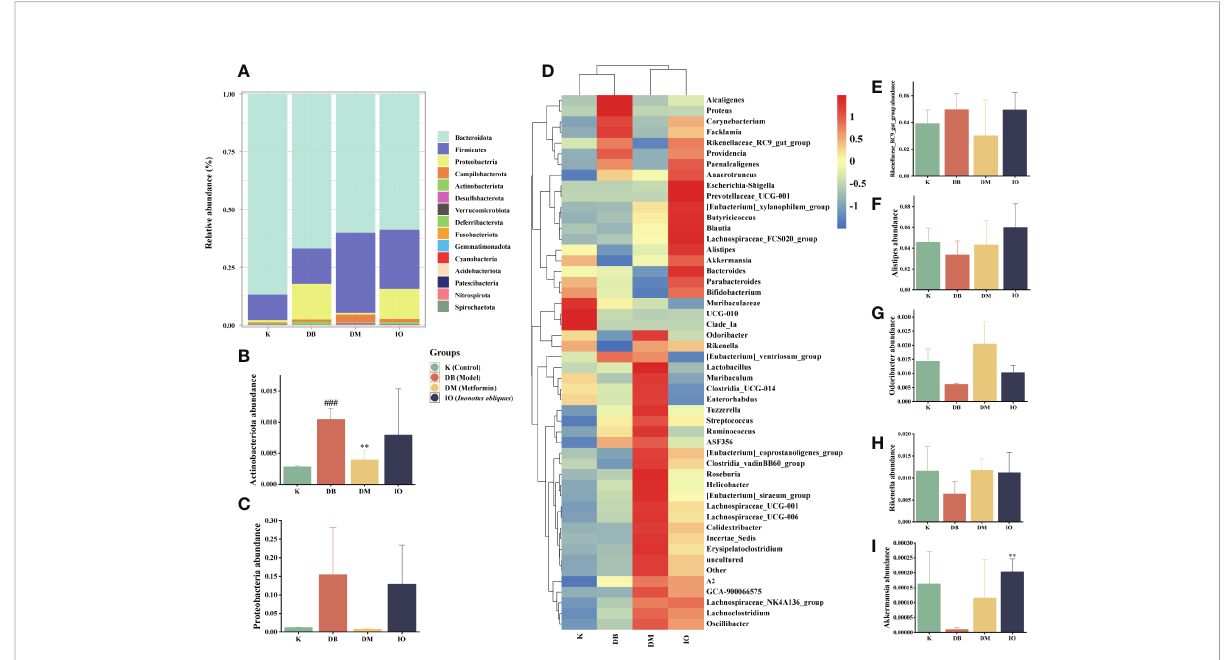
FIGURE 5 Structural changes of intestinal fl ora. Intestinal fl ora species abundance at the phylum and genus levels. (A) The relative abundance of microbial species at the phylum level in the feces of mice, (B) Actinobacteriota , (C) Proteobacteria . (D) The relative abundance of microbial species at the genus level in the feces of mice. (E) Rikenellaceae_RC9_gut_group , (F) Alistipes , (G) Odoribacter , (H) Rikenella , (I) Akkermansia . Data were expressed as the mean ± SD. ### p < 0.001 vs. K, ** p < 0.01 vs.